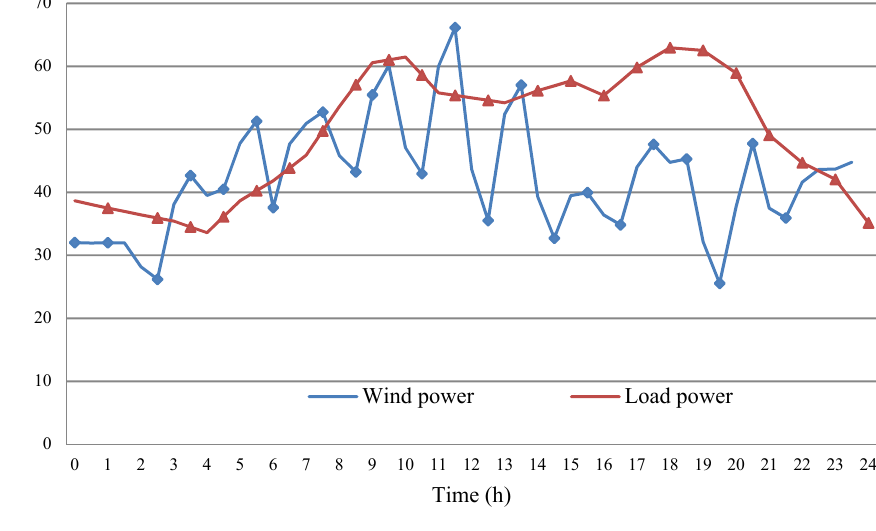
Figure 10. The prediction curve of 24